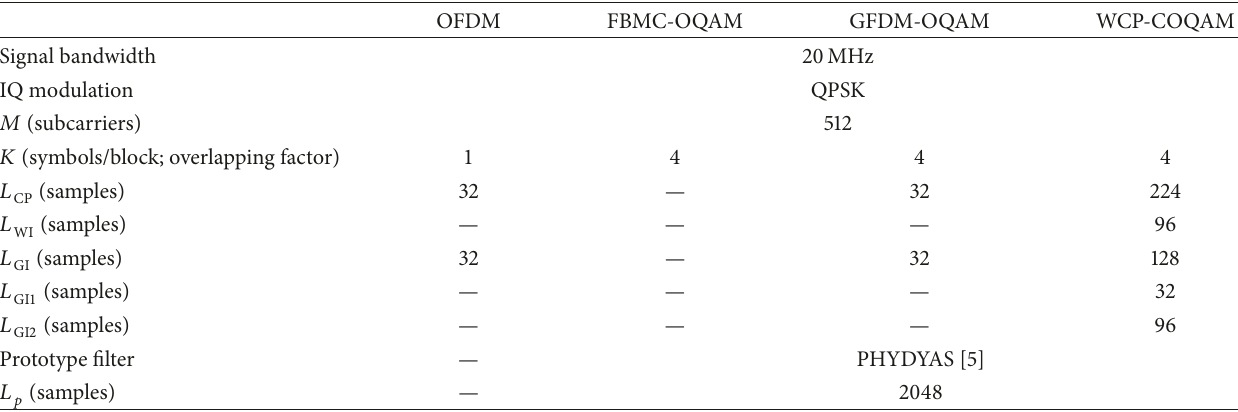
Table 1: Basic simulation parameters. Unless opposite is stated, the results shown in this work have been obtained under the conditions defined by these parameters.